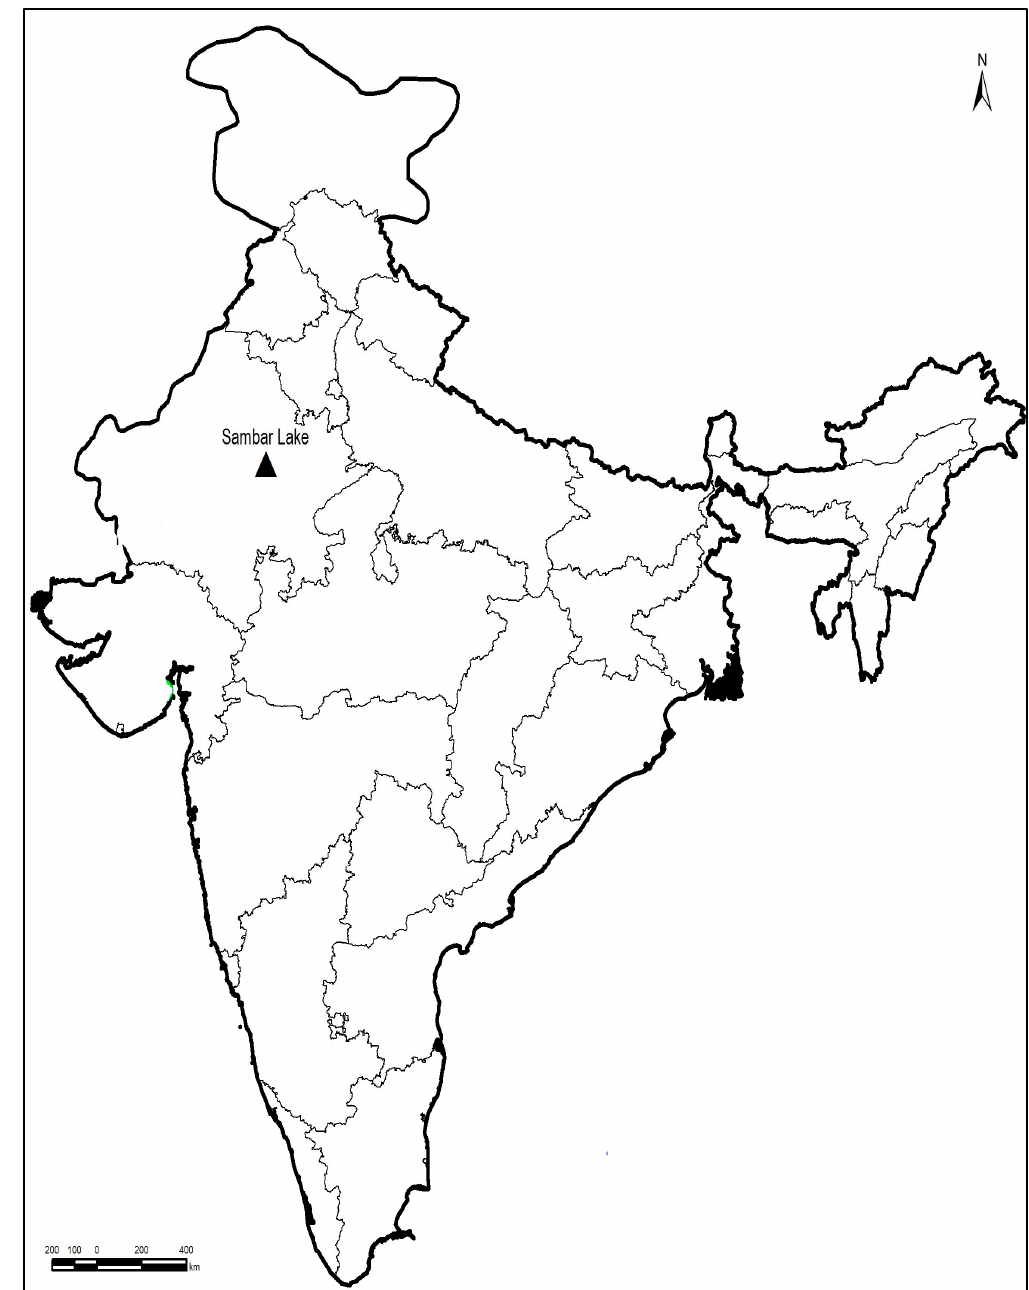
Figure 2. GIS map of the sampling site.